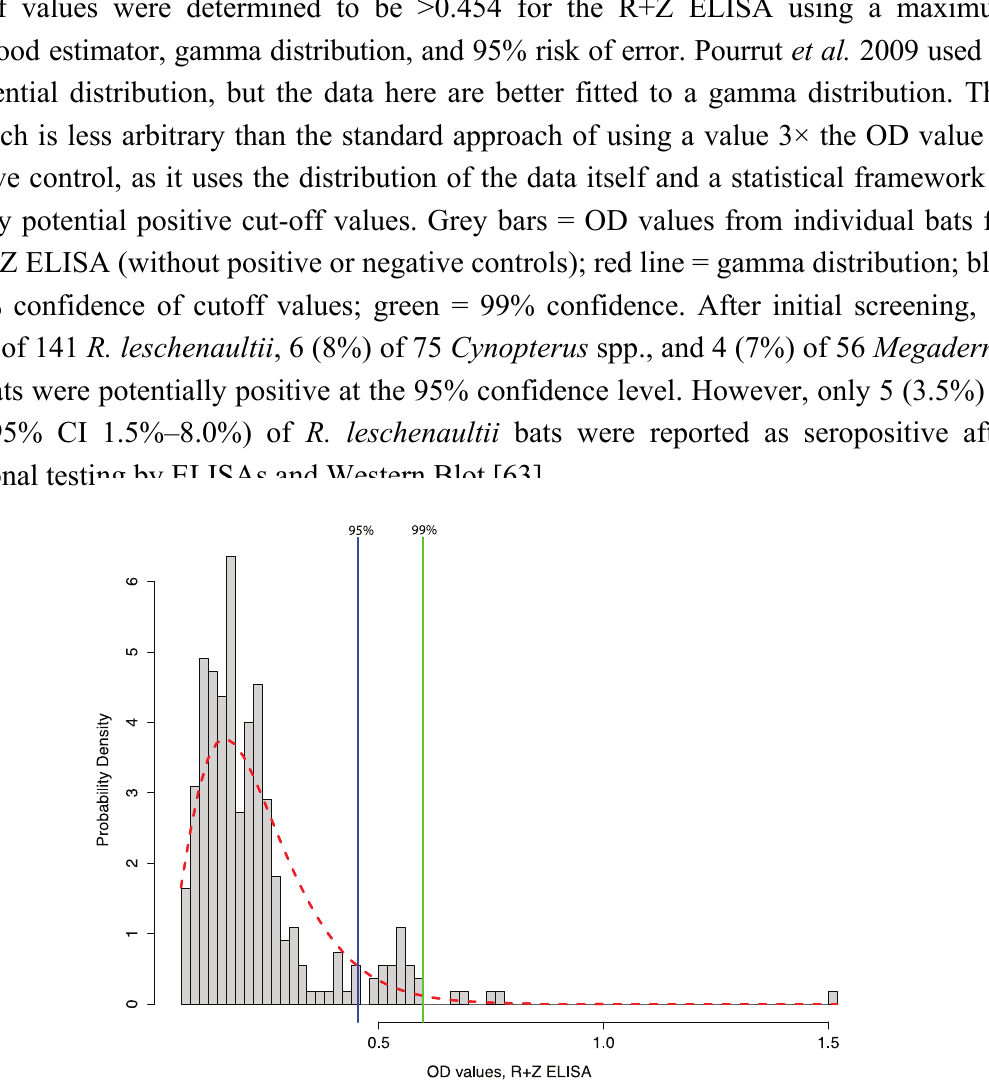
Figure 4. Methodology for determining potentially positive ( i.e. , cut-off values) for bat individuals using serological data. This figure highlights some of the challenges in